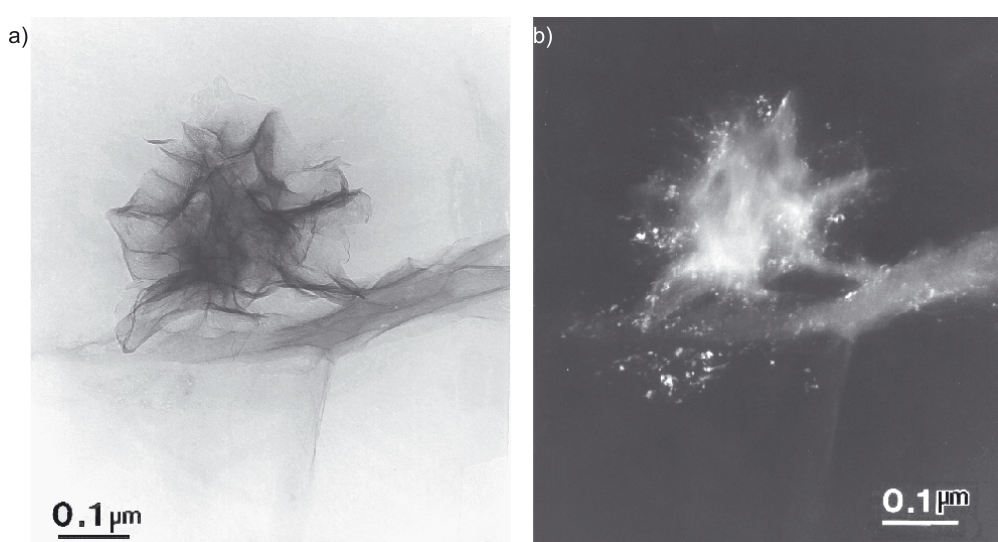
Figure 2. (a) Five-day-old pseudoboehmite transmission electron micrograph. (b) Dark field image indicates its crystallinity.